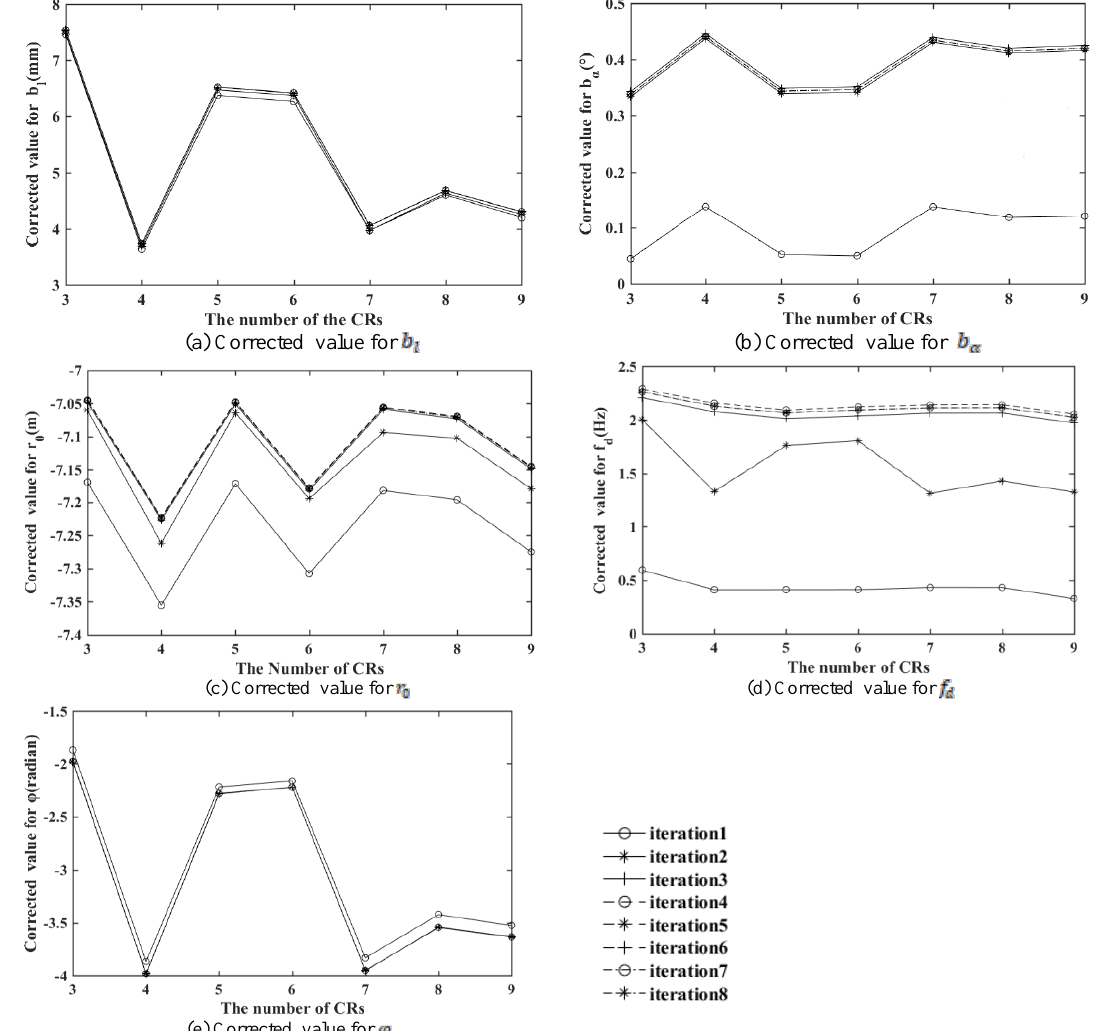
Figure 3. Corrected values of variables with respect to the different number of CRs.